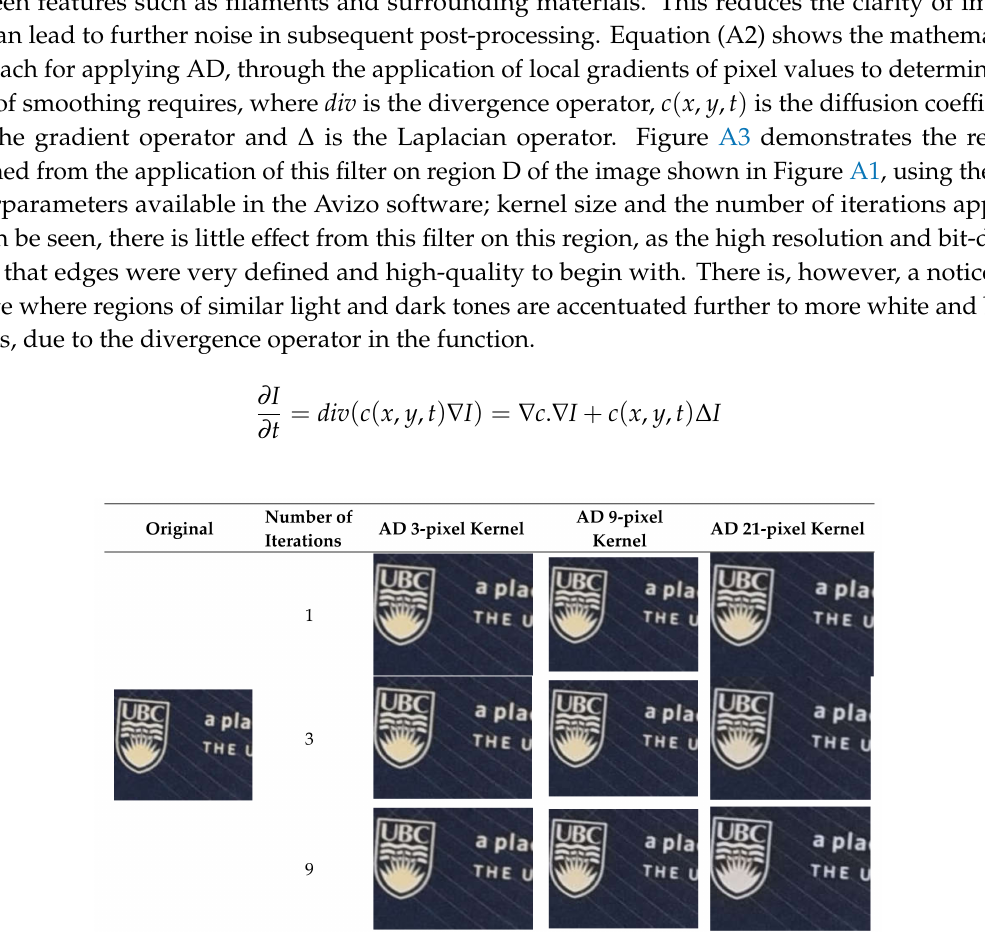
Figure A3. Comparison of the results between the original image from region D in Figure A1 to cases where the Anisotropic Di ff usion filter was applied at one, three and nine iterations (rows), in addition to varying kernel sizes of three, nine and 21 pixels